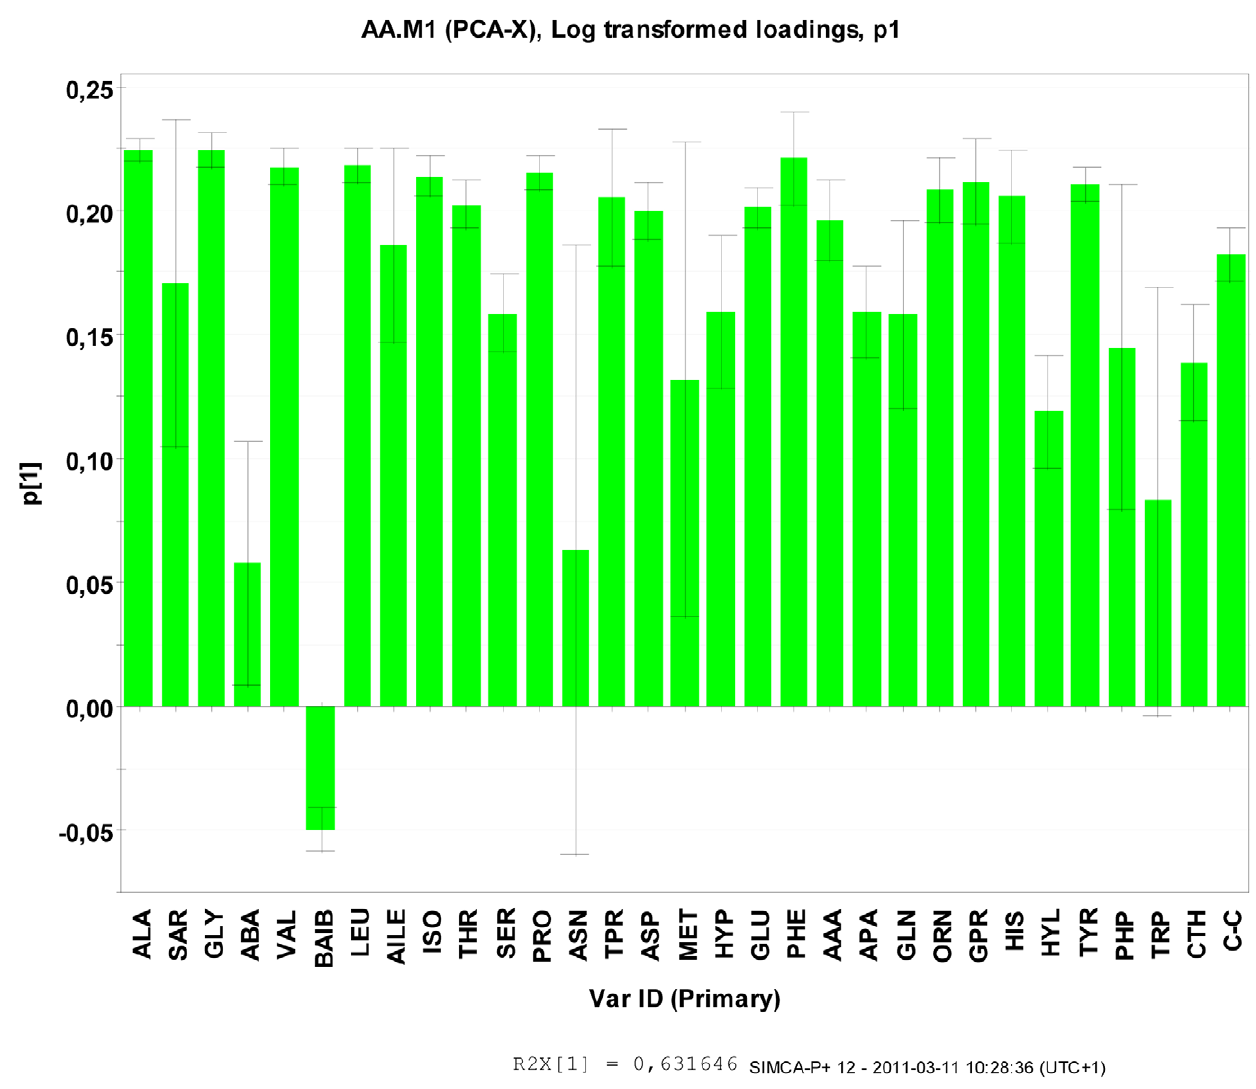
Figure 5. The p1 scores for amino acids from the cell wall extracts of S.aureus following prolonged exposure at 4 6 C for 8 weeks compared with corresponding cultures grown under ideal conditions at 37 6 C representing the reference control samples. S. aureus responded to the cold stress by generally increasing amino acid composition in this fraction relative to the control, i.e. reference samples from all three